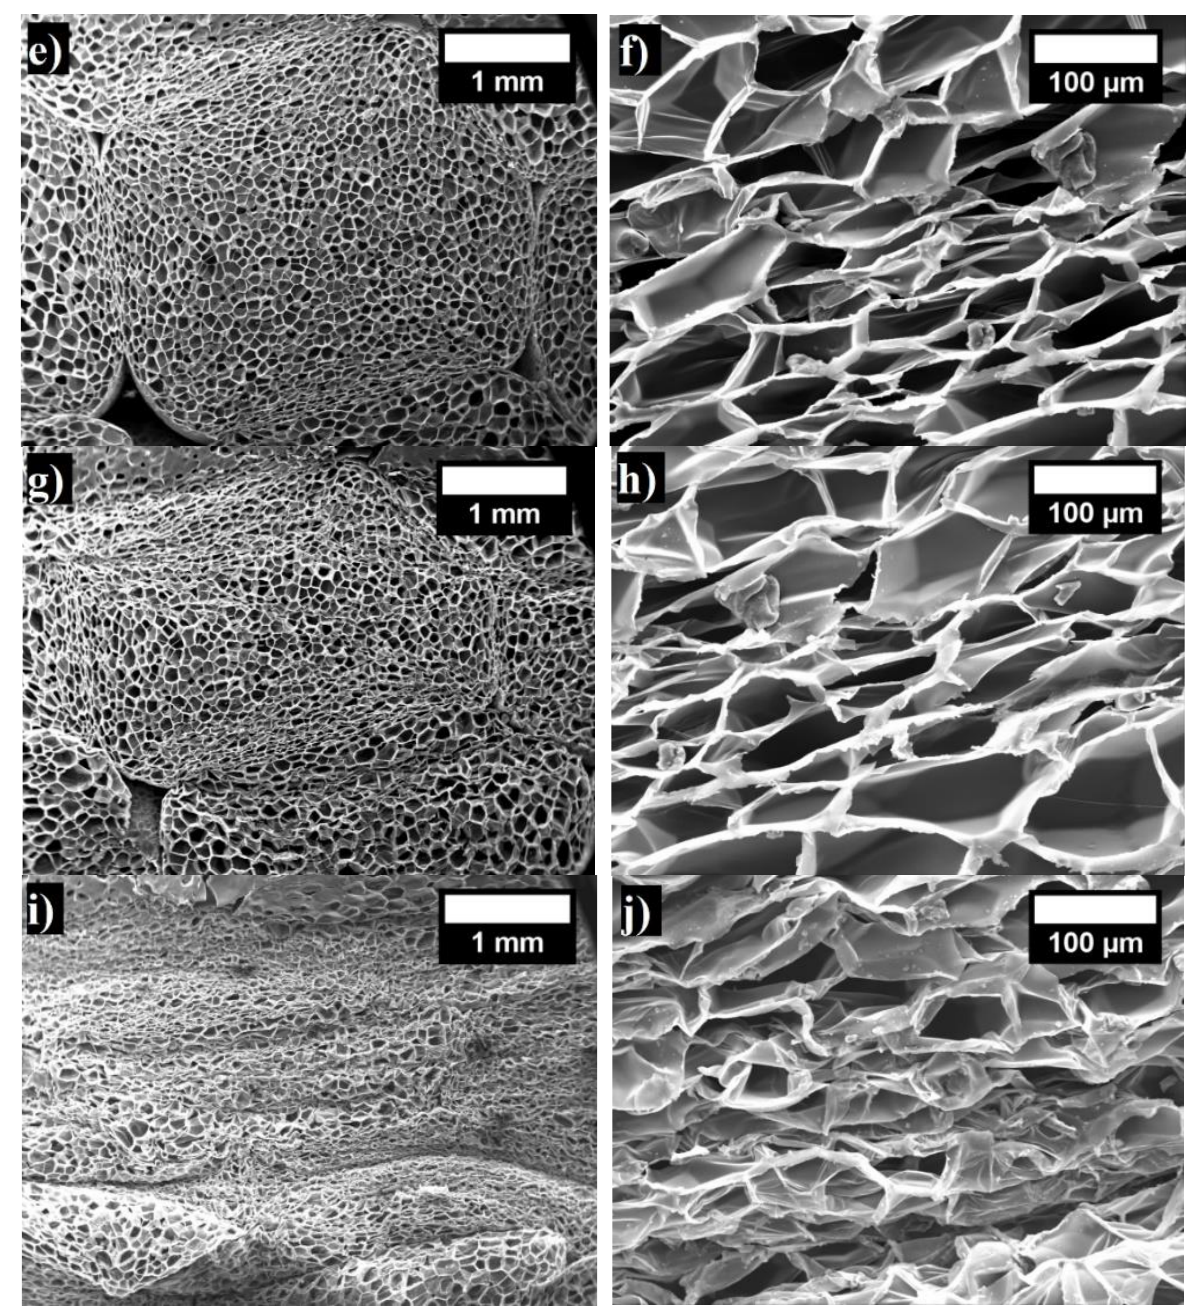
Figure 3. The changes of the 17 kg/m 3 density EPS specimen structure in the places of pore and cell connections under different levels of compression, %: ( a ) 0 (magnification ×80); ( b ) 0 (magnification ×800); ( c ) 3 (magnification ×80); ( d ) 3 (magnification ×800); ( e ) 10 (magnification ×80); ( f ) 10 (magni- fication ×800); ( g ) 30 (magnification ×80); ( h ) 30 (magnification ×800); ( i ) 60 (magnification ×80); ( j ) 60 (magnification ×800).